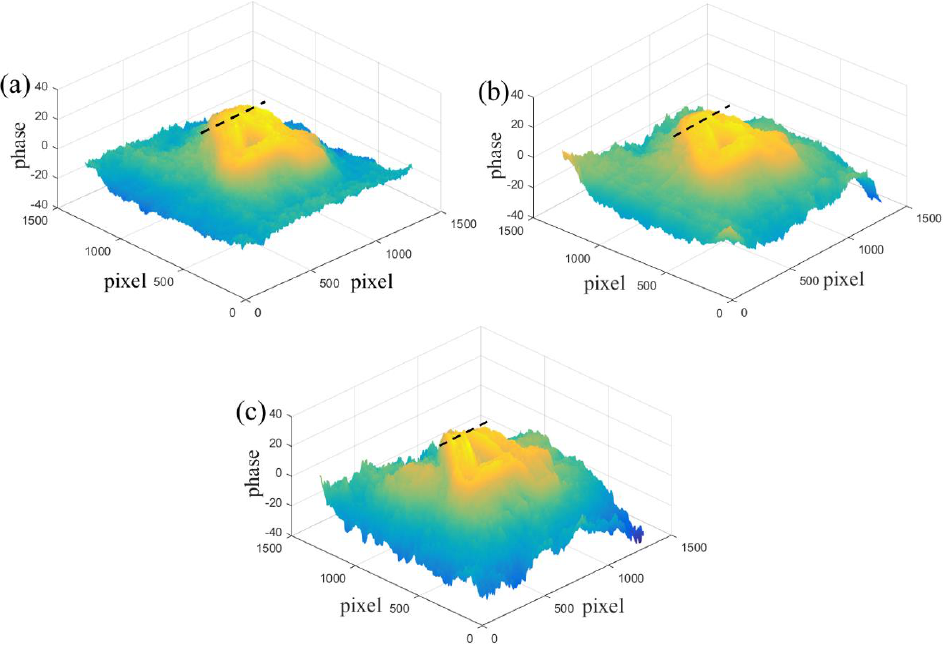
Figure 7. ( a ) Manual spatial filtering method; ( b ) method of this paper; ( c ) region − growing filtering method.